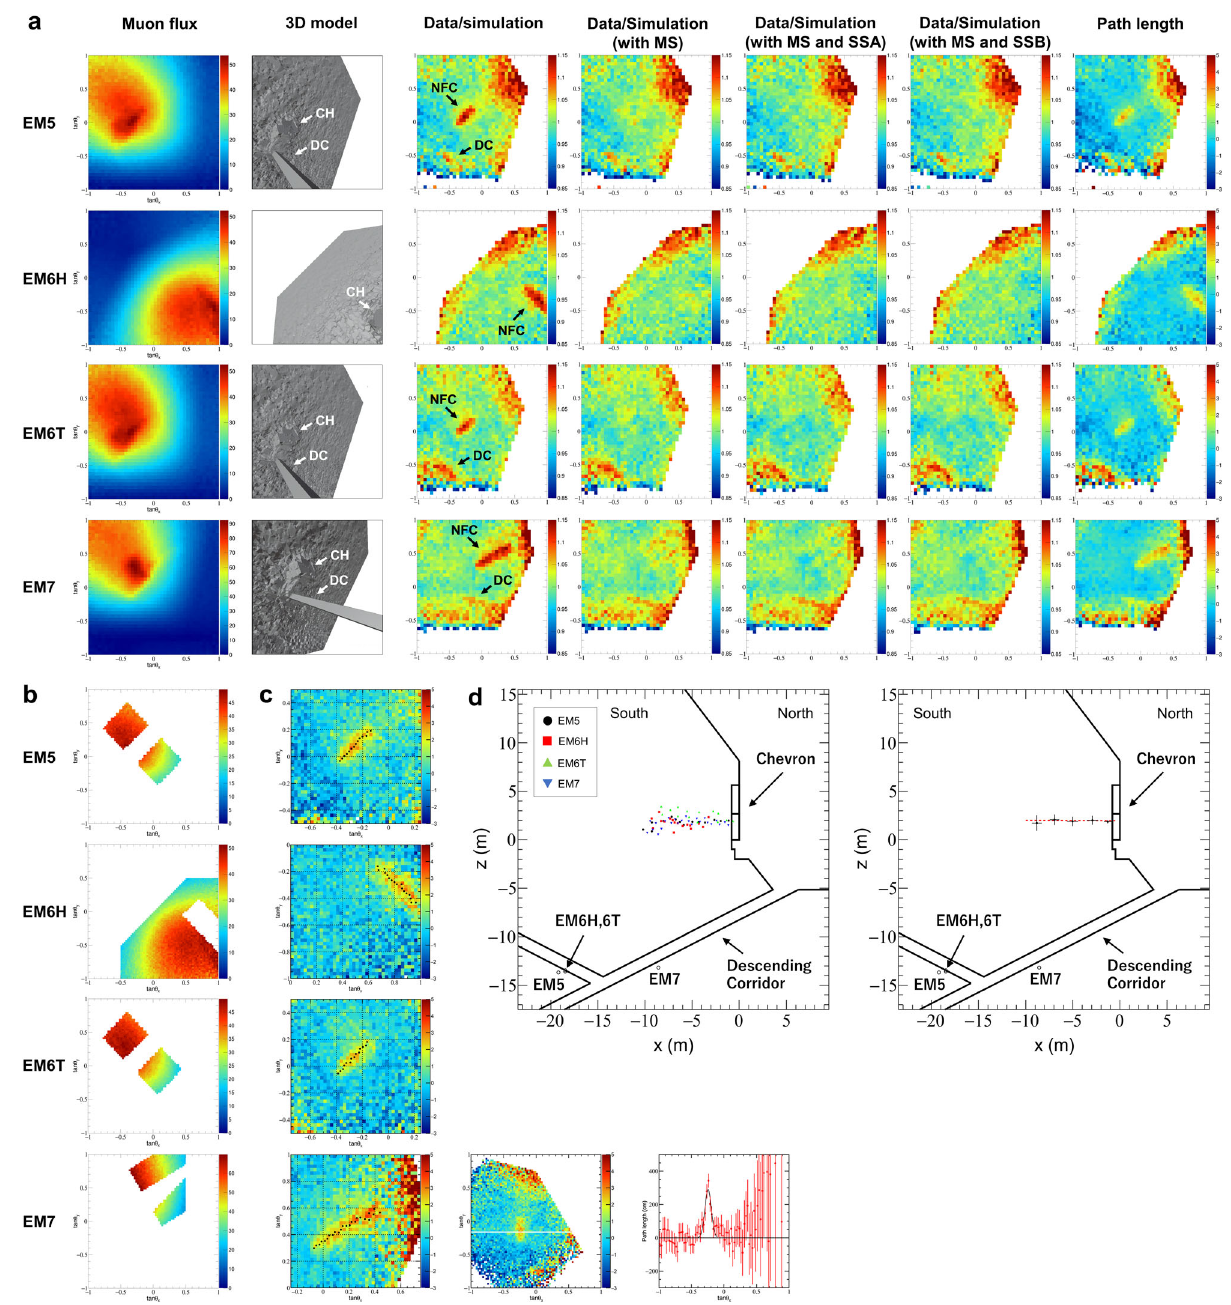
Fig. 4 | Results of the analysis of the nuclear emulsion fi lms installed in the al- Ma ’ mun Corridor. a Two-dimensional angular distribution for EM5 to EM7. From left to right: observed muon fl ux (tracks/cm 2 /day/sr), 3D model, ratioof muon fl ux of the data to simulation, with main structure (MS), with MS and sub-structure A (SSA),with MS and sub-structureB (SSB),and path length with differencebetween the data and simulation. The resolution is tan θ = 0.050. CH denotes the Chevron. b The area used for normalization. c Left panels show two dimensional angular distribution with enlarged area including NFC of path length difference between the dataand simulation with the resolution oftan θ = 0.025.The black dotsare the direction to the center ofthe NFC, obtained by taking a cross section everytan θ = 0.025 and fi tting it (Methods). Center panel shows an example of path length differenceobtainedby EM5,and the coordinate system isrotatedto takethe cross section for fi tting, which is perpendicular to the longitudinal direction (North-